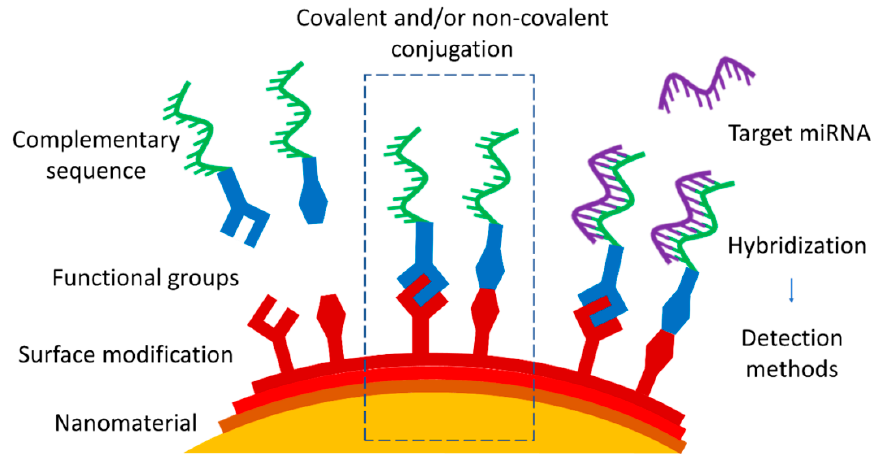
Figure 1. Position of the focus of this review, i.e., approaches of nanomaterial functionalization by covalent or non-covalent conjugation with complementary miRNA or DNA sequence as a part of the strategy of miRNA nanoprobe development.